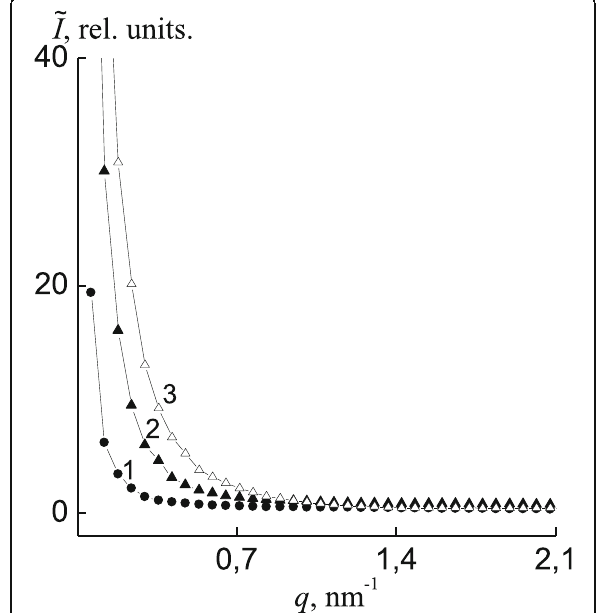
Fig. 3 SAXS-intensity profile patterns of 1 the IPEC pectin – P4VP, 2 the IMC pectin – Ag + – P4VP, and the 3 IPEC – Ag 0 nanocomposite